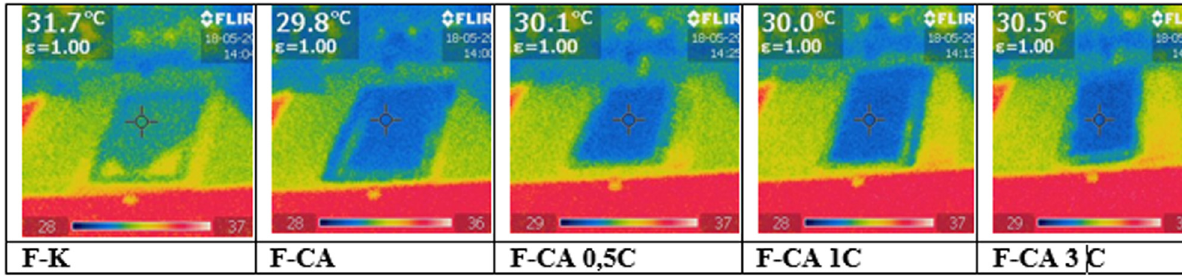
Figure 9: Thermographs of samples after 5 min